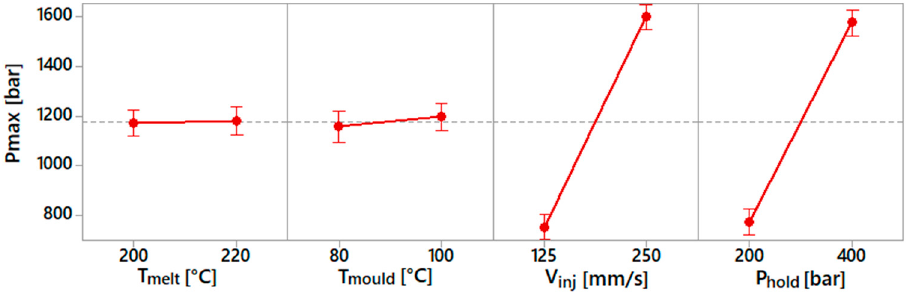
Figure 8. Main e ff ect plot for maximum injection pressure. Figure 8. Main effect plot for maximum injection pressure.